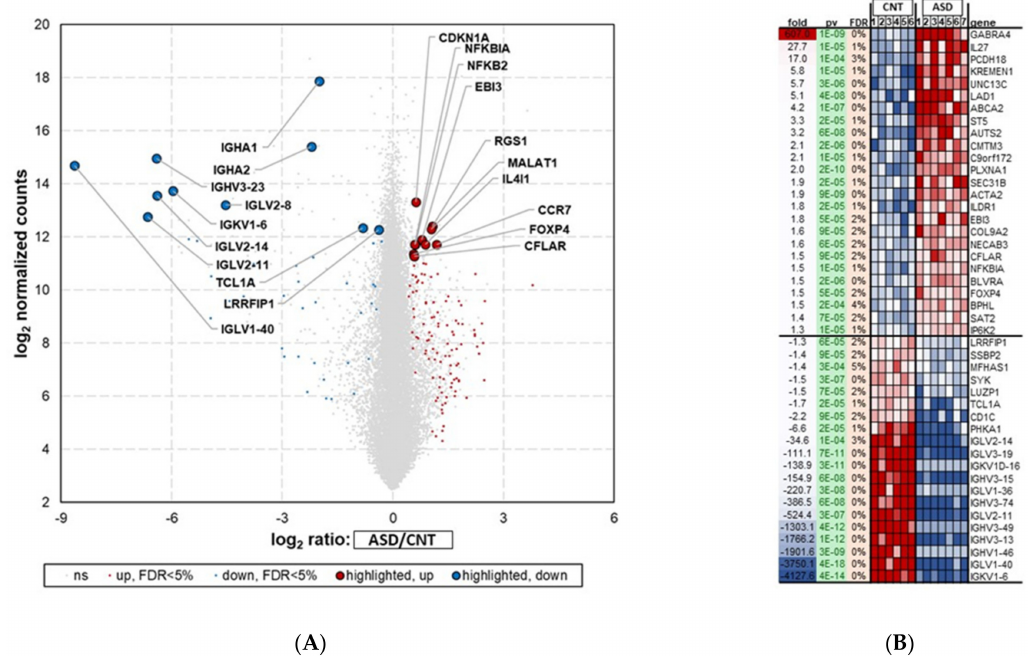
Figure 2. RNA-seq analysis showing differential expression of top 45 mRNAs in LCL groups—ASD ( n = 7) and CNT ( n = 6)—with FDR < 5%. Samples with poor alignment rates which were dropped from differential expression analysis, included 3 from ASD group and one from Control group. ( A ) Volcano plot of differentially expressed mRNAs (DEGs) in ASD and CNT LCLs. ( B ) Heatmap of DEGs in ASD and CNT LCLs. ASD = Autism, CNT = Control, Fold = Fold Change, pv = p -value and gene symbol. Red dots are upregulated, blue dots are downregulated, and grey dots indicate no change; FDR = false discovery